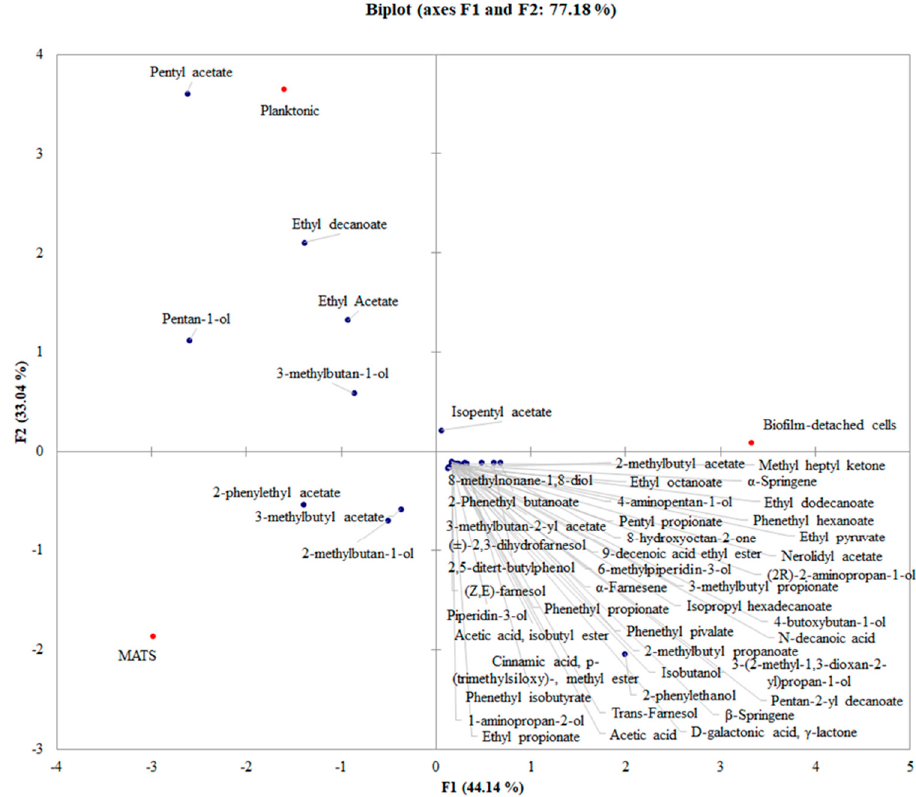
Figure 6. The biplot (score and loading) of the first two principal components encompassing aroma compounds released in the different lifestyle .